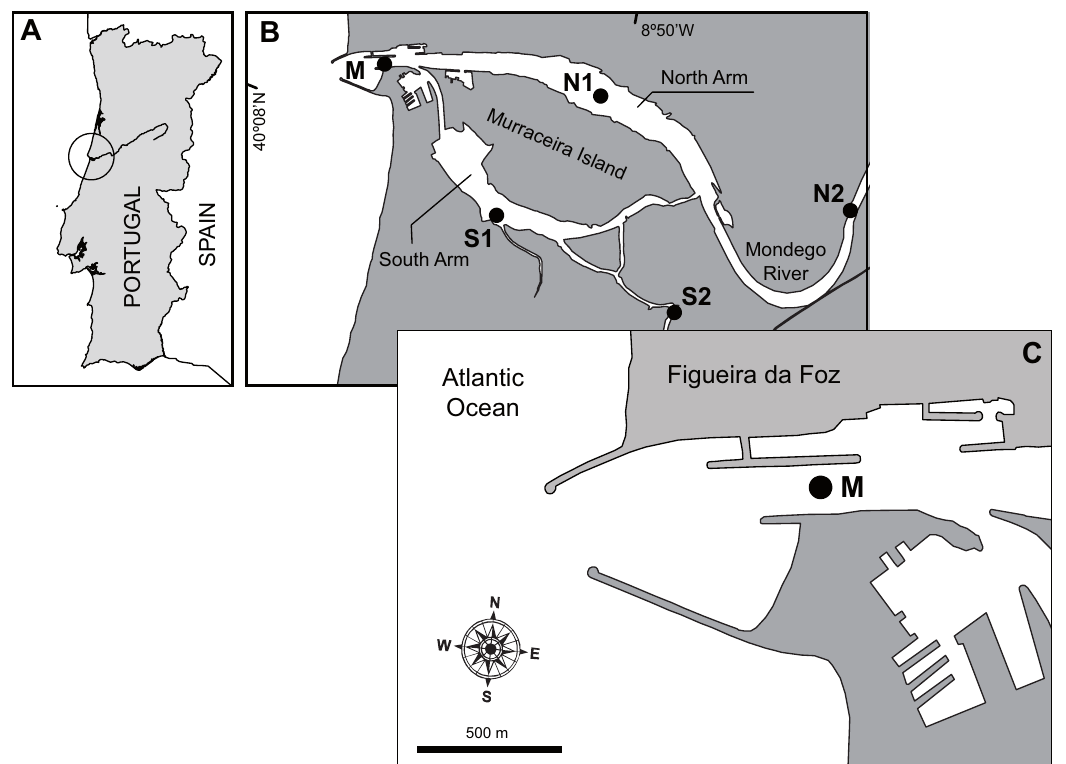
Fig. 1 . – Mondego estuary location on the west coast of Portugal (A). Sampling stations sampled inside the estuary (B) in both south (S1, S2) and north arm (N1, N2) and detailed location of sampling site M (high-frequency sampling)